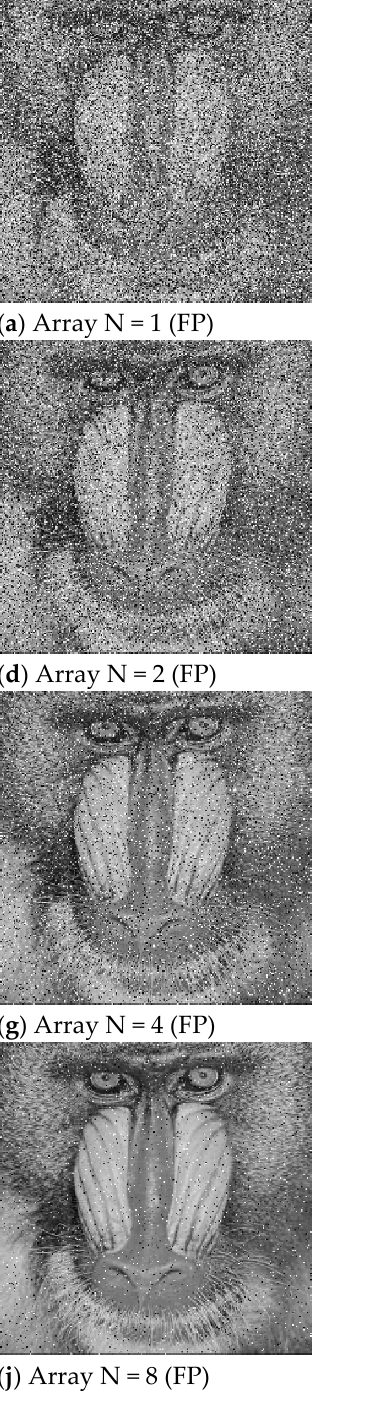
Figure 7. Comparison of denoising effect of Baboon image.